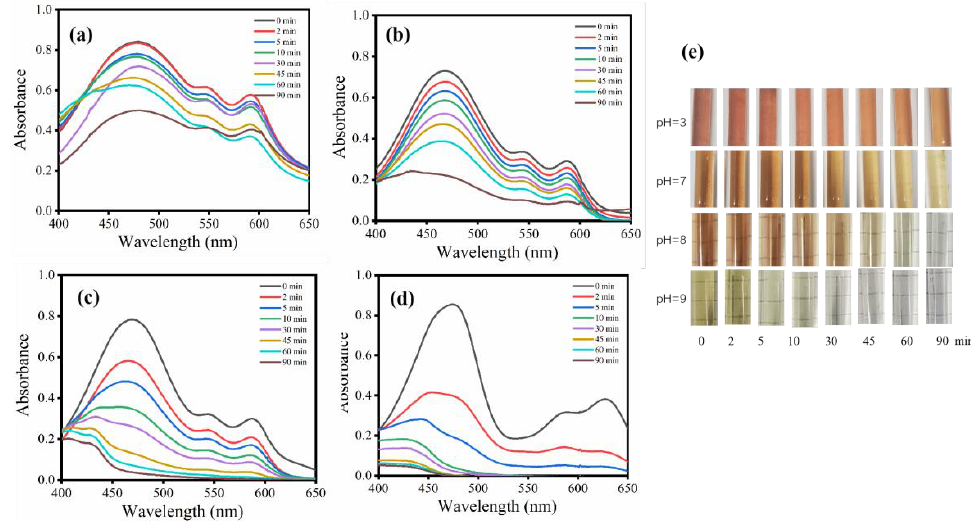
Figure 7. Influence of pH on the self-degradation of the HYP aqueous solution. ( a ) pH = 3, ( b ) pH = 5, ( c ) pH = 7, ( d ) pH = 8, ( e ) pH = 9, and color changes during the self-degradation of HYPs.